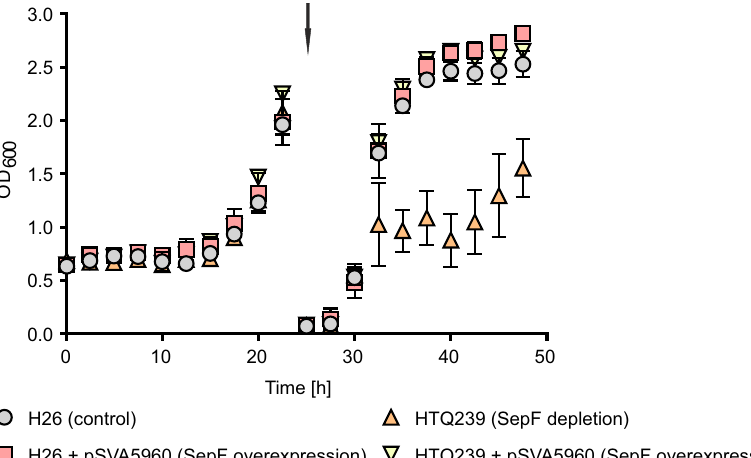
Fig. 5 Growth curve of H26 and HTQ239 overexpressing SepF in the presence and absence of tryptophan. Growth curve of H26 (gray), H26 + pSVA5960 (red), HTQ239 (orange) and HTQ239 + pSVA5960 (yellow) grown in CAB-medium supplemented with tryptophan and uracil. All four strains grew the same before dilution into CAB-medium without tryptophan (indicated by the arrow). After dilution, HTQ239 stopped growing while the other strains grew unaffectedly. Moreover, additional expression of SepF from plasmid pSVA5960 had no effect on the growth of H26 and even complemented the growth defect of HTQ239 in medium without tryptophan. The data for this growth curve was acquired from three independent cultures per strain. Error bars indicate the standard (Supplementary Fig. 8c). HTQ239 cells expressing FtsZ2-GFP